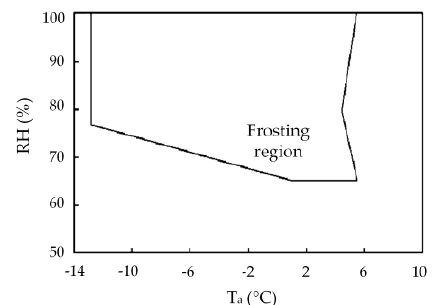
Figure 6. Frosting map given by Jiang et al. [69].